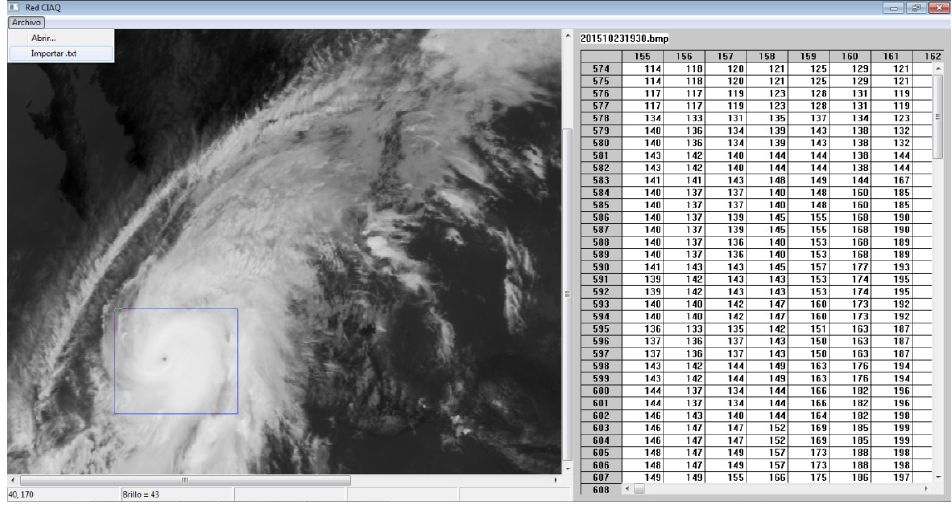
Figure 1. Extraction of the brightness temperature value of the pixels, using the Sat-Viewer ® .